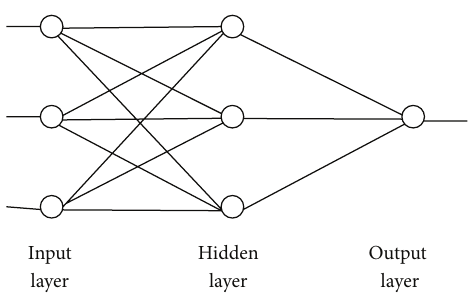
Figure 1: Architecture of BP neural